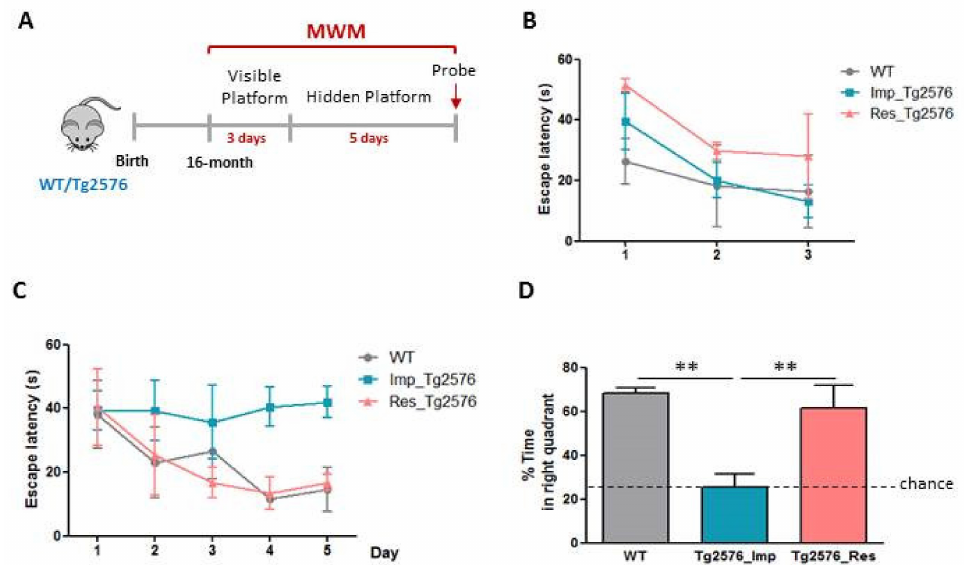
Figure 1. Identification of Tg2576 cognitive resilient mice through MWM test. ( A ) Diagram showing the MWM paradigm used to identify aged-Tg2576 mice with cognitive resilience. ( B ) Escape latency to the visible-platform phase of the MWM test for WT, Imp_Tg2576 and Res_Tg2576 mice. ( C ) Escape latency to the hidden-platform in the MWM test for WT, Imp_Tg2576 and Res_Tg2576 mice. ( D ) Percentage of time spent in the correct quadrant during the probe trial on day 6 (one way ANOVA test followed by Newman-Kewls post hoc test, n = 3–4, ** p ≤